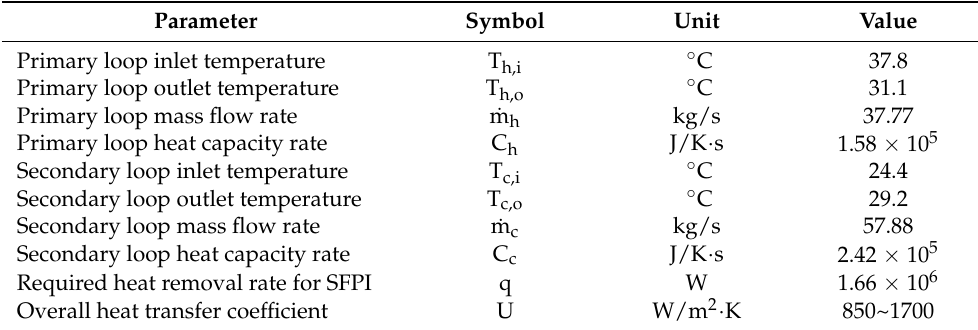
Table 16. Operating parameters